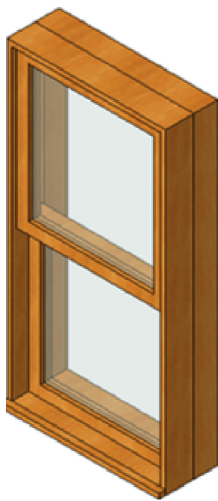
Figure 8: BIM model of test case